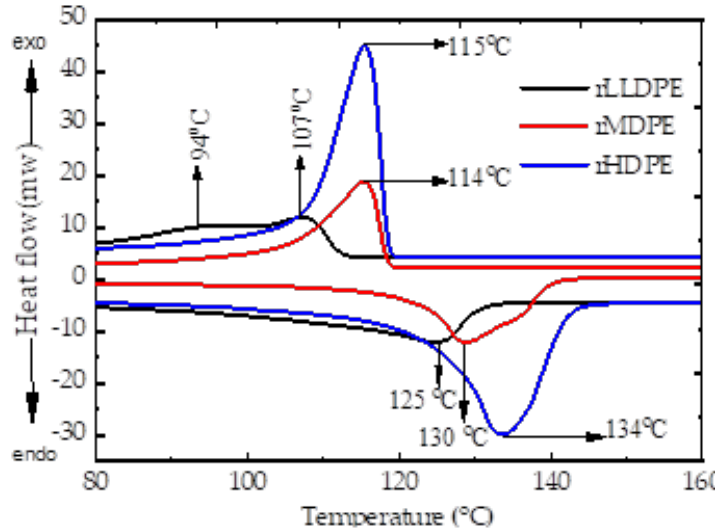
Figure 6. DSC graph of endothermic and exothermic heating cycle. Table 4. Crystallization and melting process values of recycled